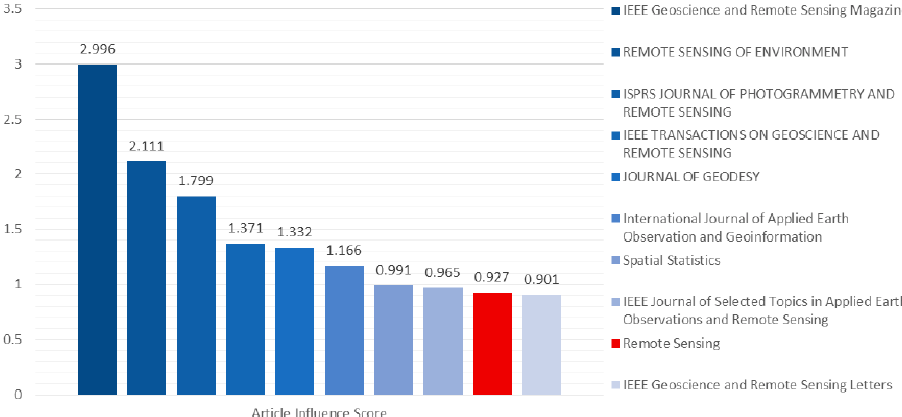
Figure 10. The top 10 journals under the category “Remote Sensing” based on Article Influence Score (2019). Data were calculated from Web of Science on 13 July 2020.